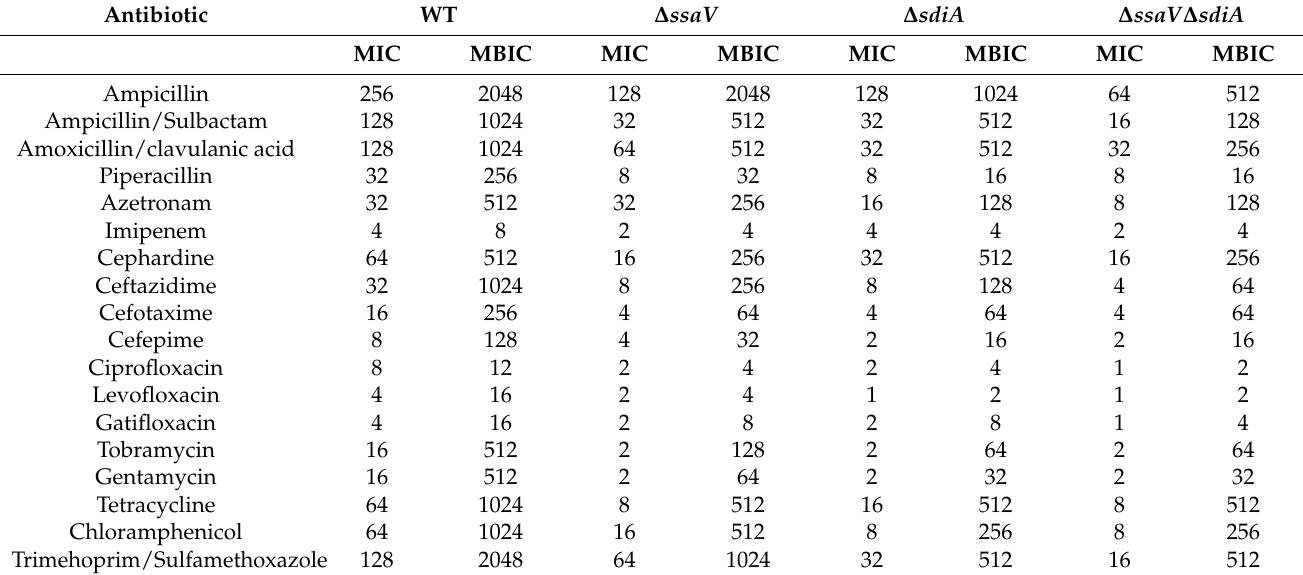
Table 2. MICs and MBICs ( µ g/mL) of tested antibiotics against S. Typhimurium strains *.